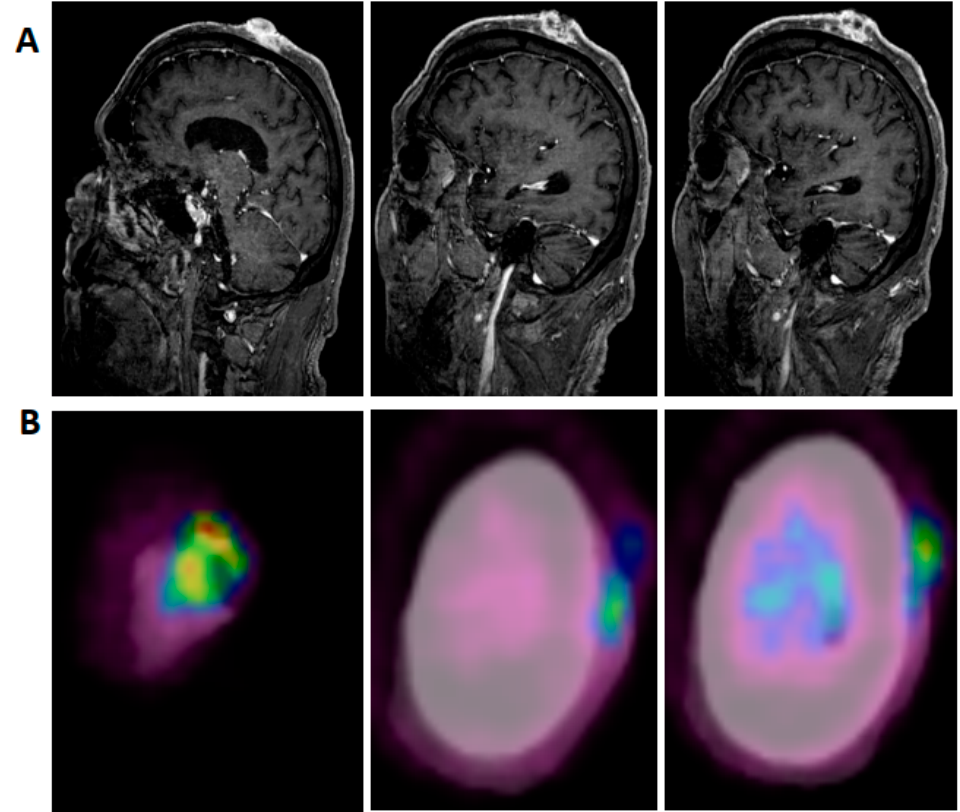
Figure 1. Representative pre-treatment, post-contrast, T1-weighted, sagittal MRI images ( A ) and fused PET-CT images ( B ) show disease extension predominantly from the vertex scalp to the left lateral temple region.